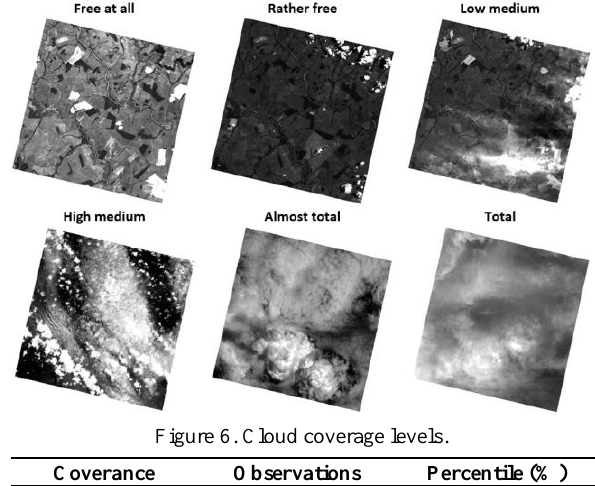
Figure 6. Cloud coverage levels.